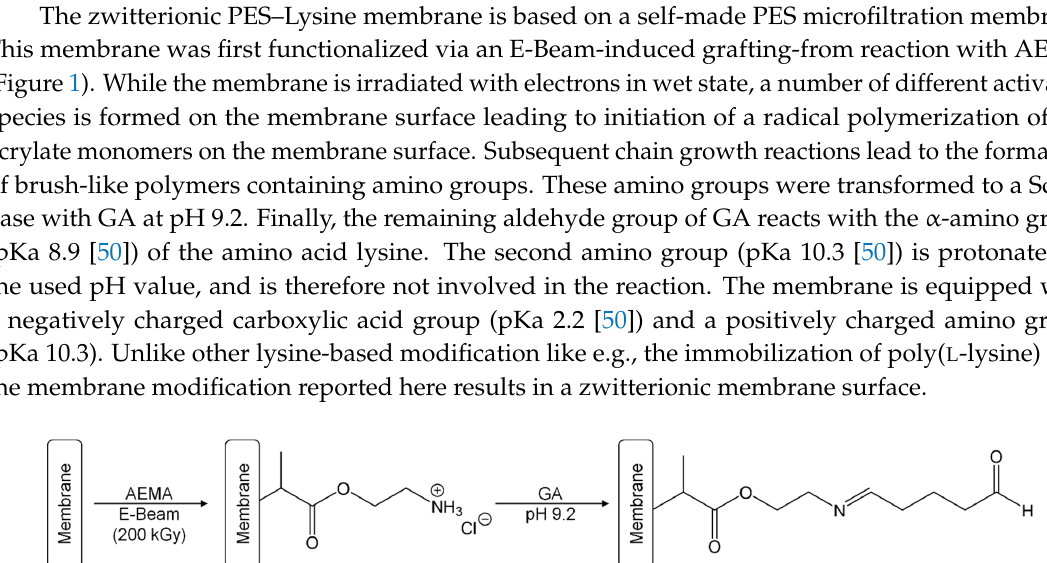
Table 1. Characteristics of pristine PES and PES–Lysine